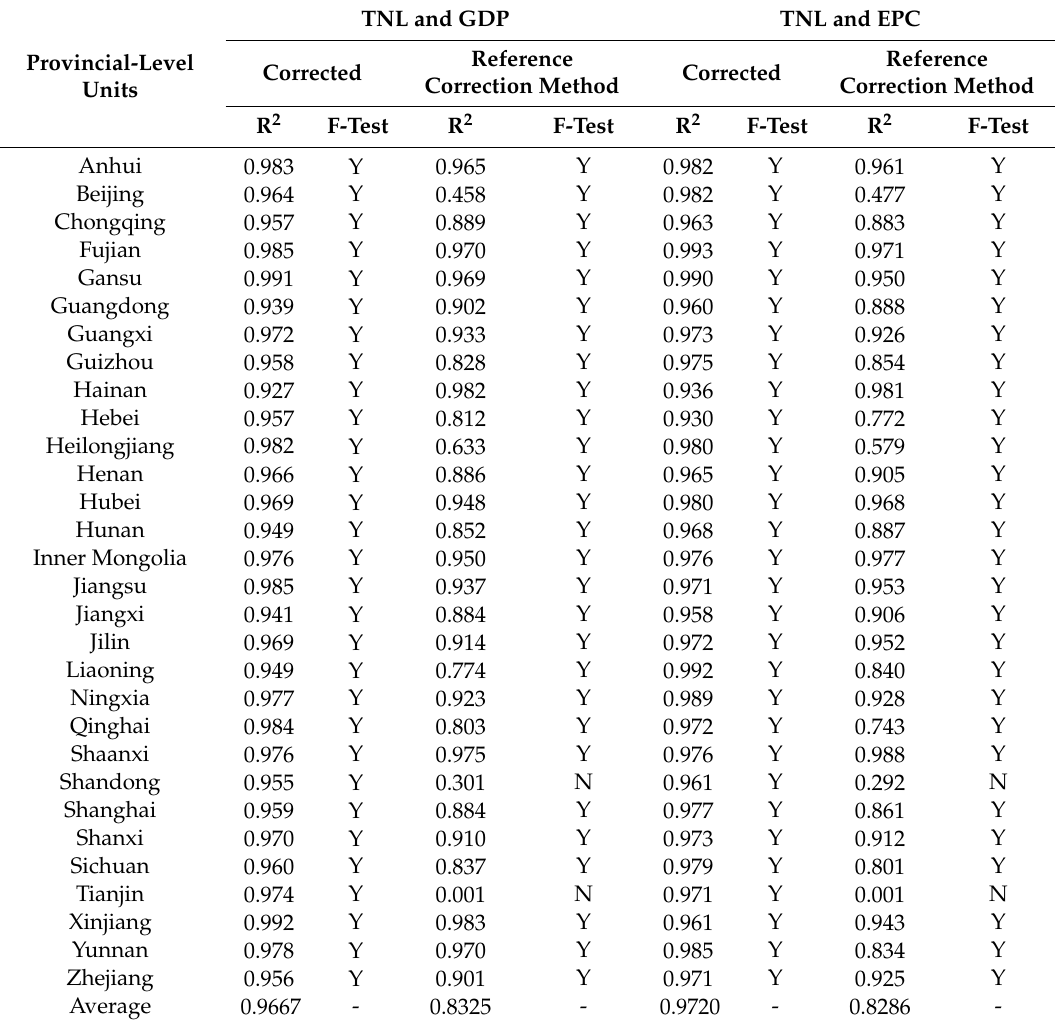
Table 11. R 2 values and F-tests of the regression analyses for prefectural units of each province. Note: Y represents the regression equation has passed the F-test at the 0.001 level, N represents the regression equation has not passed the